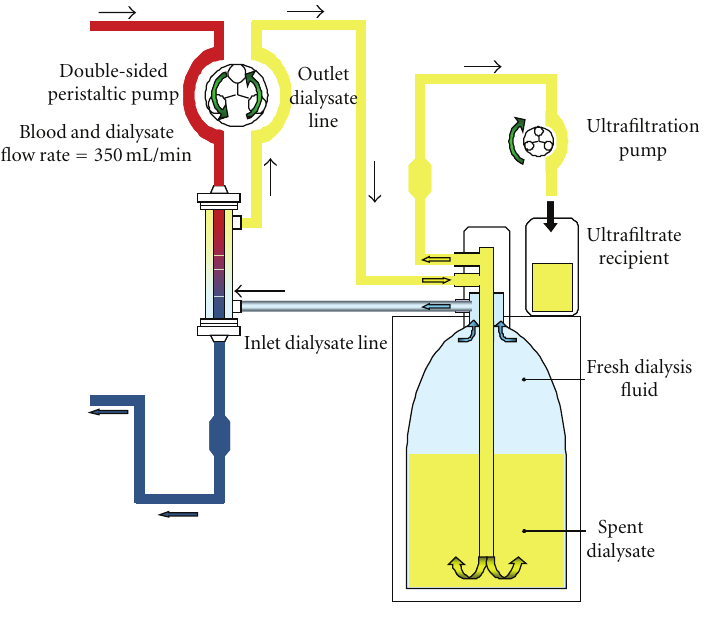
Figure 1: Flow chart of the GENIUS single-pass batch dialysis